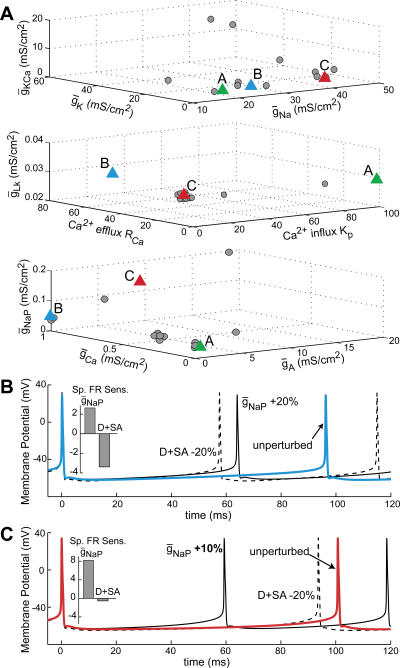
Evaluating Sensitivity for Optimized Models Across Parameter Space(A) Location in nine-dimensional parameter space of the 15 optimized passive dendrite models (gray circles and colored triangles), shown in three 3-D subspaces: [
,
,
] (top); [Kp, RCa,
] (middle); and [
,
,
] (bottom). Voltage traces and sensitivity coefficients of three models represented as colored triangles (A, B, and C) are compared in (B), (C), and Figure 4.
(B) Comparison of morphologic (D + SA) and active parameter (
) perturbations of the model labeled “B” (blue triangles in [A], above). Solid blue line represents the somatic voltage trace of the unperturbed model. Dashed line shows the response to a 20% decrease in D + SA; solid black line shows the response to a 20% increase in
. Inset barplot shows the normalized sensitivity coefficients of spontaneous firing rate to D + SA and
(Sp. FR Sens.): positive to
, negative and of greater magnitude to D + SA.
(C) Perturbations of the model labeled “C” (red triangles in [A], above). Shown are perturbations analogous to those in (B) above, except that the solid black line shows the response to a 10% increase in
. Sensitivity to D + SA is small and negative, while sensitivity to
is large and positive. Note the difference in scale between the sensitivity barplot insets in (B) and (C).